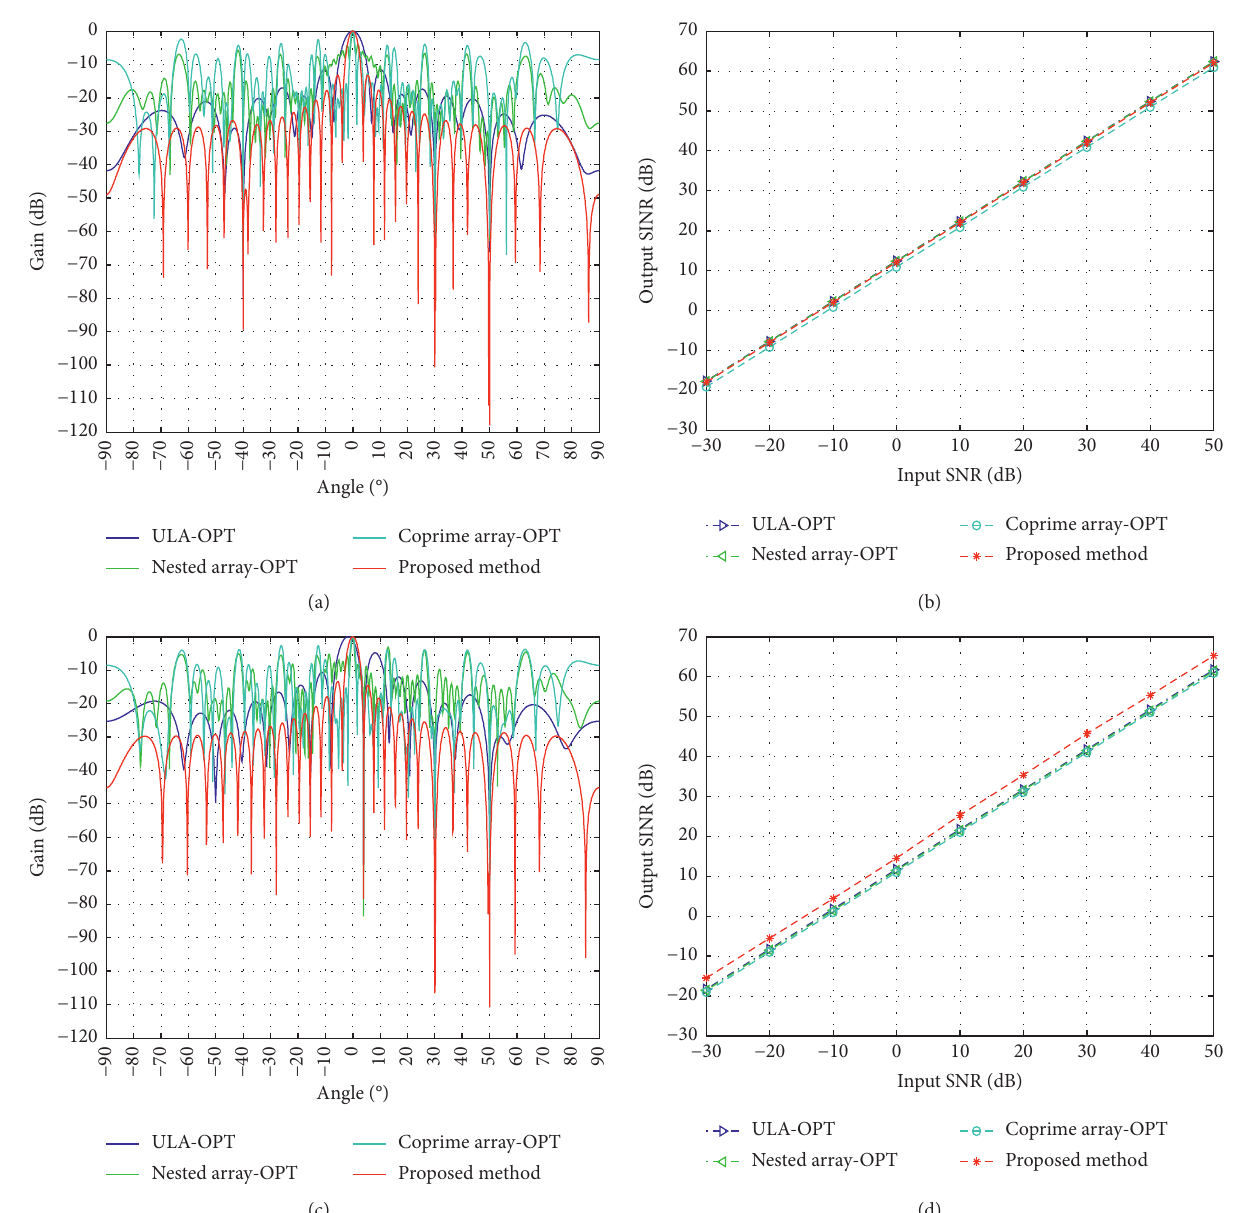
Figure 5: Second example: (a) beampattern in the case of sidelobe interferences, (b) output SINR versus input SNR while suppressing sidelobe interferences, (c) beampattern in the case of mainlobe and sidelobe interferences, and (d) output SINR versus input SNR while suppressing mainlobe and sidelobe